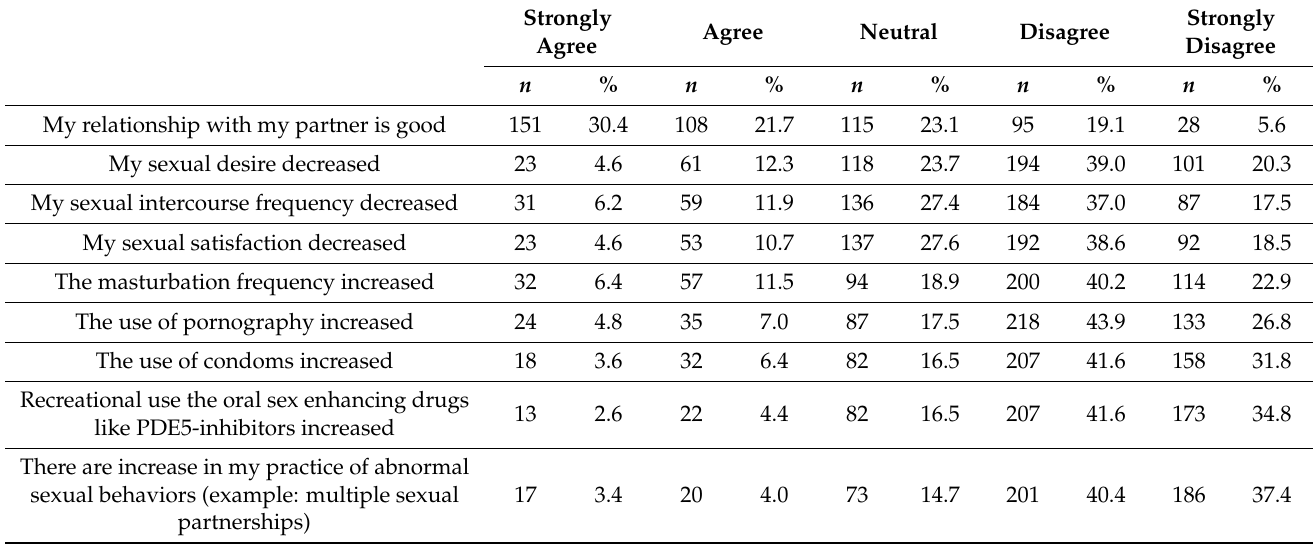
Table 5. Sexual behavior and partner sexual relationship during the COVID-19 pandemic lockdown period ( n =